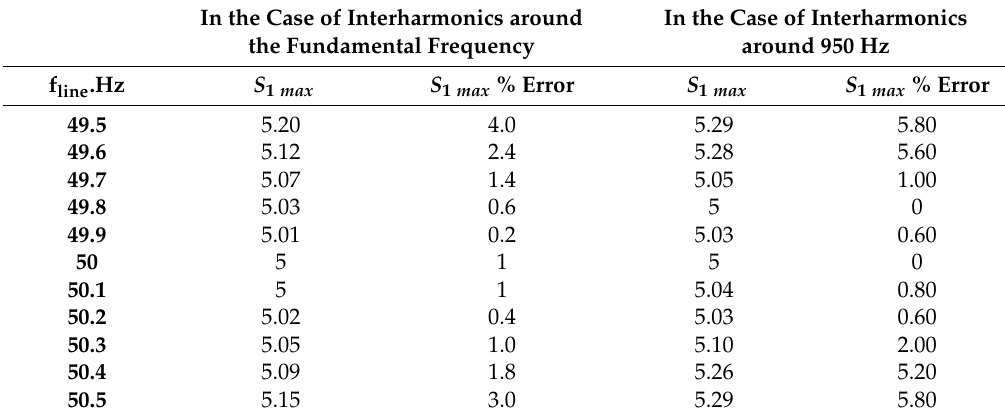
Table 7. Response of proposed flickermeter in the case of Equations (50) and